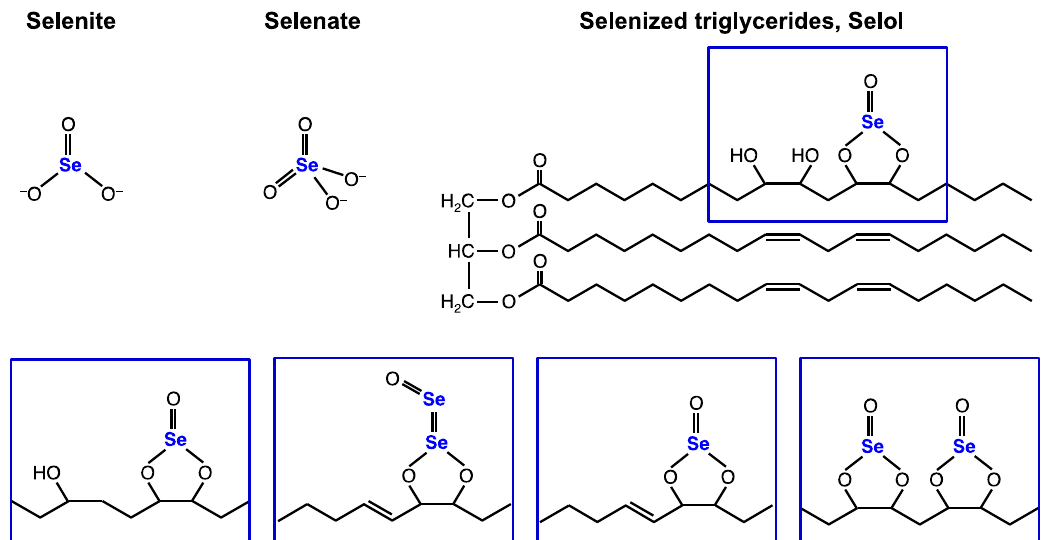
Figure 2. Chemical structures of selenite, selenate and Selol. In Selol, a complex mixture of at least 11 selenitriglyceride compounds have been characterized by high performance liquid chromatography-electrospray ionization tandem mass spectrometry (HLPC-ESI MS n ) [19] .